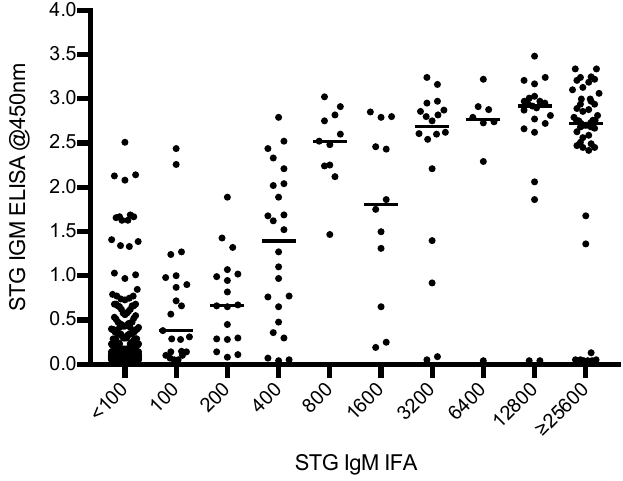
Figure 1. Distribution of InBios Scrub Typhus Detect™ immunoglobulin M (IgM) ELISA optical densities (ODs) compared with immunofluorescence assay (IFA) IgM for admission and convalescent samples.